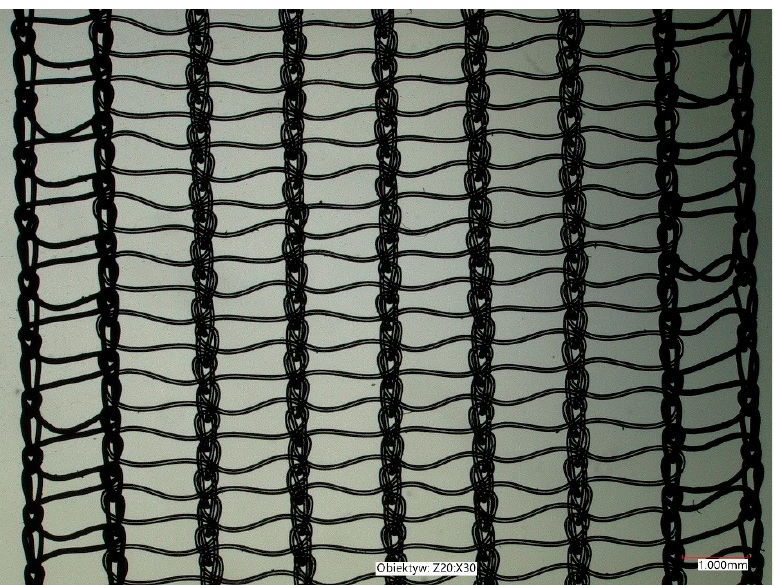
Figure 2. The structure of Dallop ® NM ULTRALIGHT.